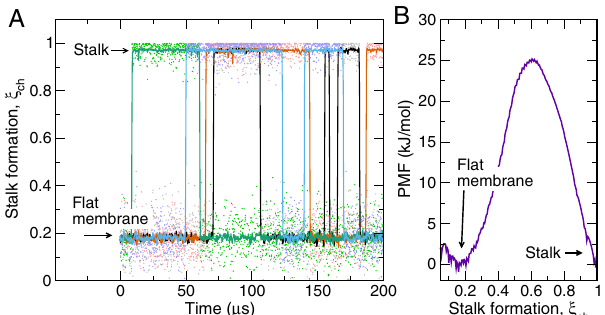
Fig. 2 Unbiased simulations con fi rm the free energies of stalk formation. A Free simulations of stalk formation and closure. Colors indicate four independent simulations of 200 μ s each. ξ ch ≈ 0.2 and ξ ch ≈ 1 correspond to the fl at membrane and the stalk, respectively. Eight transitions of stalk formation and 7 transitions of stalk closure occurred within a total simulation time of 800 μ s. The simulation system contained purely POPC lipids and 1.8 water beads per lipid between the proximal lea fl ets (5.6 water beads per nm 2 ). Lipids were modeled with the beta-3.2 release of Martini 3.0. B PMF of stalk formation for the same system, revealing a free energy of stalk formation of Δ G stalk ≈ 0 kJ/mol, in excellent agreement with the free simulations. Source data are provided as a Source Data fi le.